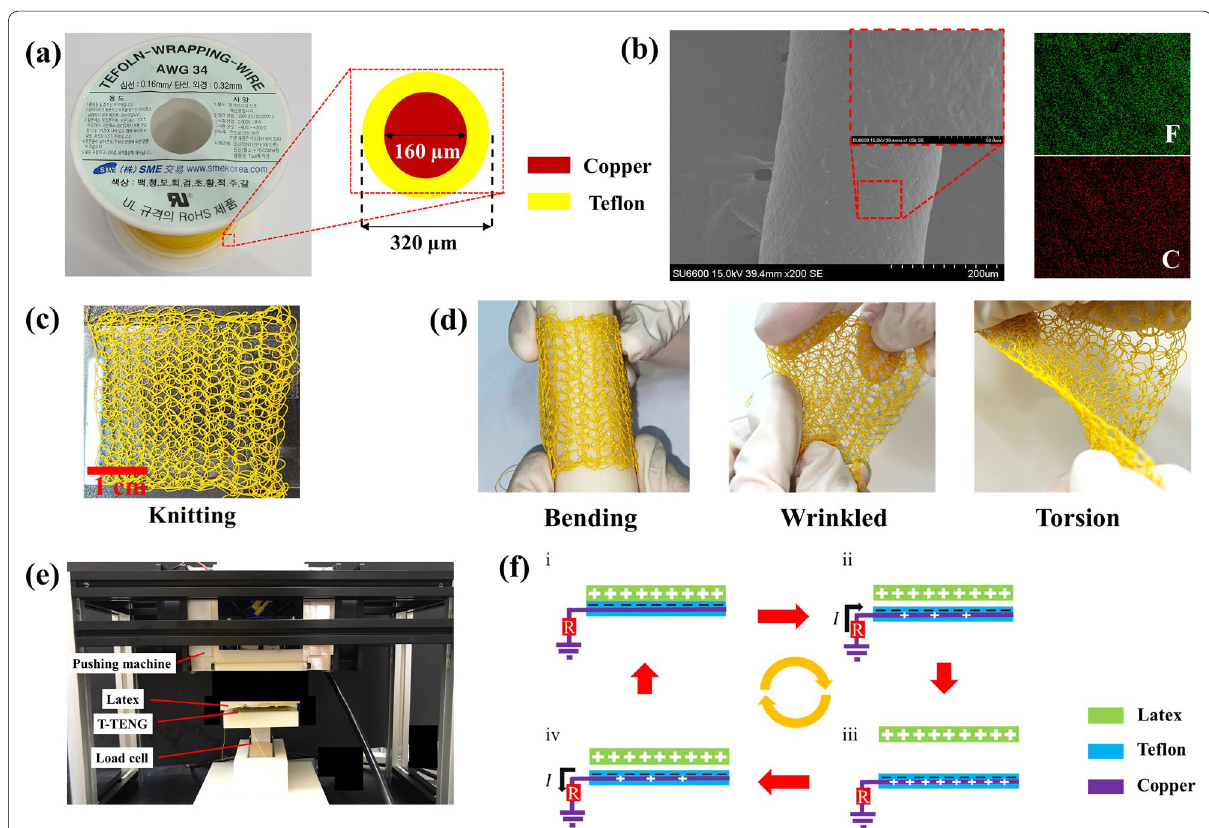
Fig. 1 a Photograph and b SEM image and EDS analysis of commercial Teflon wrapping wire. c T‑TENG produced by knitting methods. d Photograph of fabricated T‑TENG with flexible properties. e Experimental setup to characterize T‑TENG. f Mechanism of